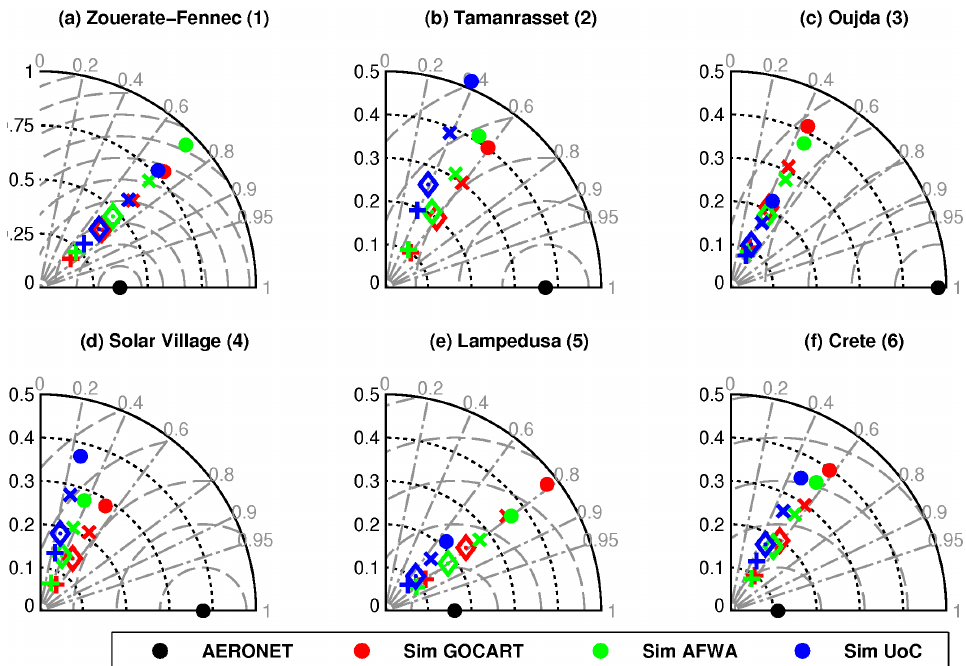
Figure 10. Taylor diagram comparing time series of AOD for all simulations to the AERONET station observations as shown in Fig. 9. Root mean square error lines are plotted with a 0.1 interval. Symbol annotations are the same as in Fig. 4.